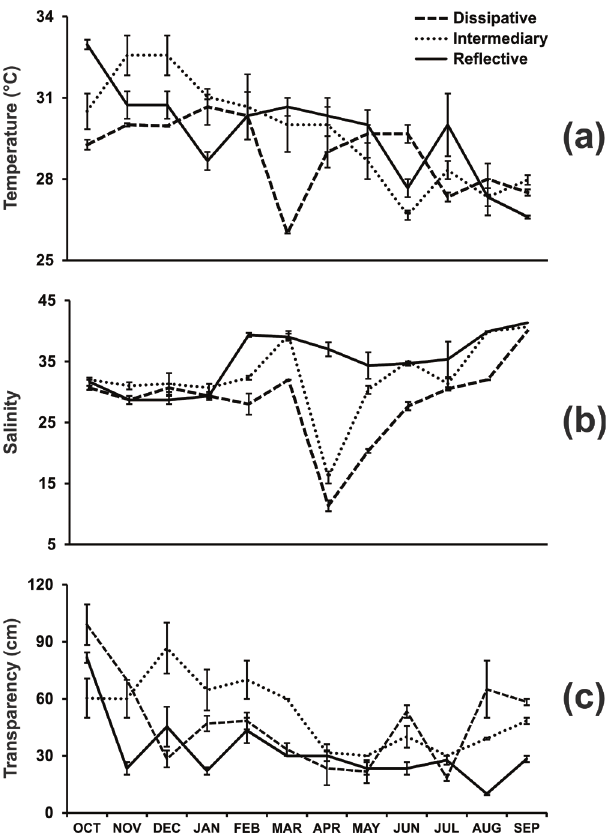
Fig. 2. Mean monthly variations of the environmental variables ( ± SE) for the study